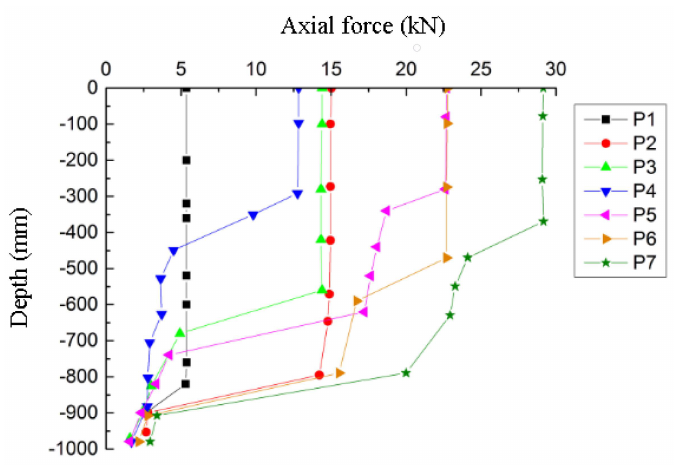
Figure 9. Axial force transfer curve of seven kinds of pile under the ultimate vertical